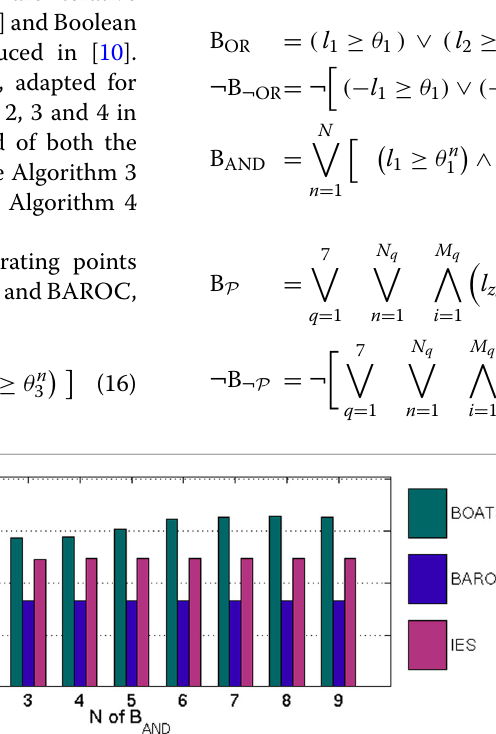
Fig. 8 Experiments 1. Comparing context change detection performance of BOA B AND (16) with different conjunction multiplicities N when the thresholds are selected by different